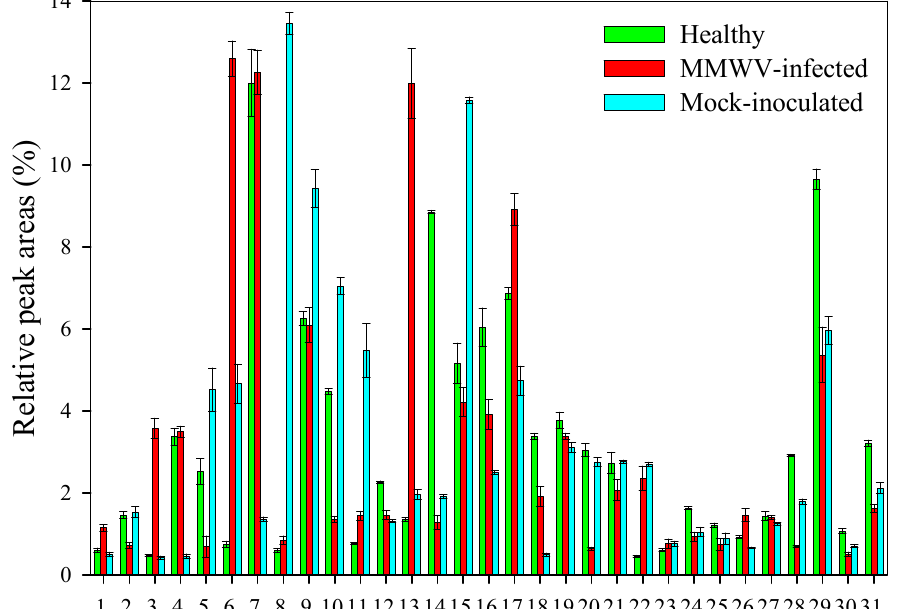
Figure 4. VOCs released from healthy, Mikania micrantha wilt virus (MMWV)-infected, or mock-inoculated plants. Quantitative analyses of each volatiles organic compound (expressed as area percentage) were carried out by a peak area normalization measurement. Values are mean ± SE (three replicates). 1, Hexanal; 2, 2-Hexenal; 3, α -Ocimene; 4, α -Cubebene; 5, α -Copaene; 6, α -Curcumene; 7,